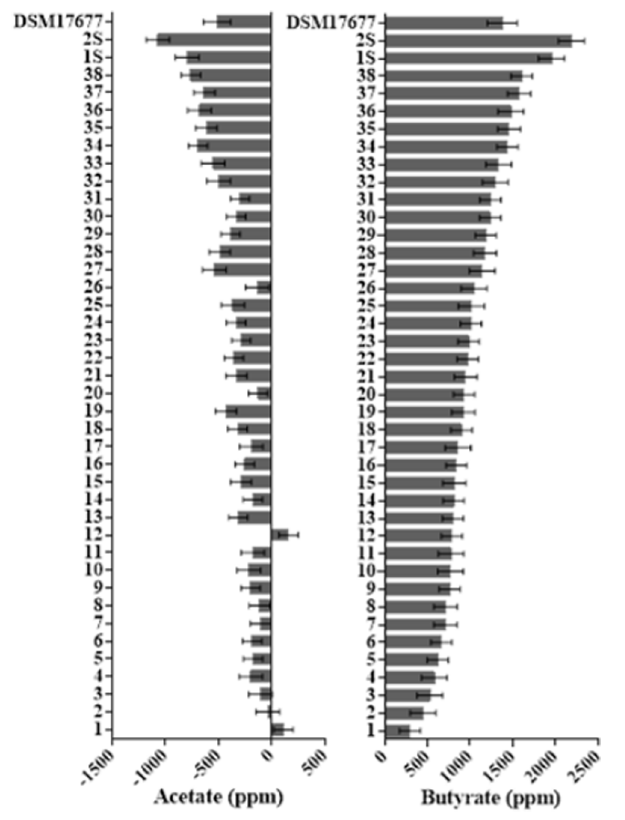
Fig. 2. Average difference of acetate and butyrate concentrations in the growth media after 48 h of incubation of each F. prausnitzii isolate. The bars represent the mean concentration in ppm. Error bars indicate the standard error of the mean. Based on the butyrate production, the F. prausnitzii isolates were entitled from 1–38 (bovine), and 1S and 2S (swine).